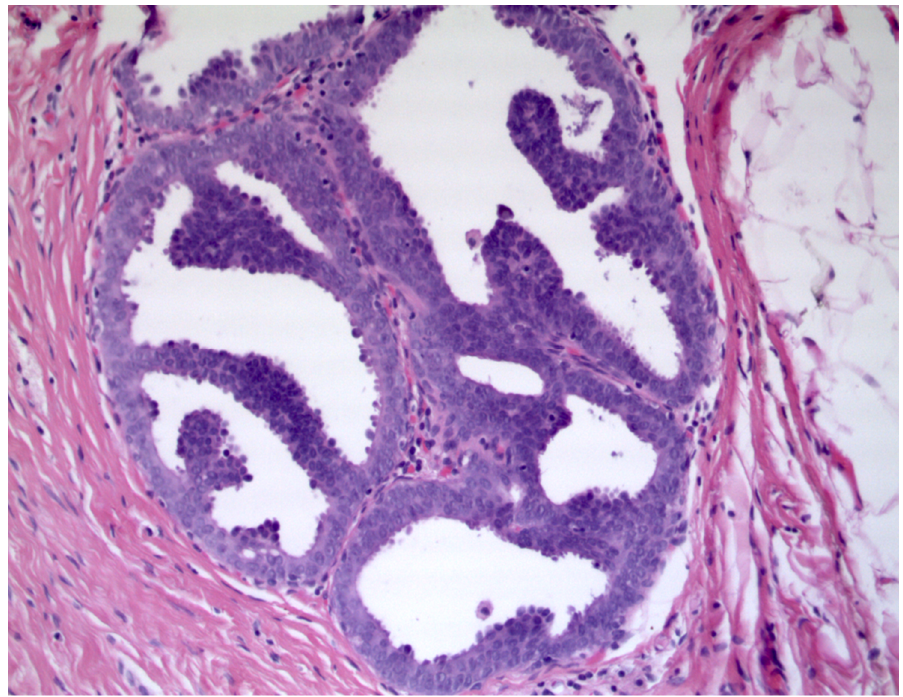
Figure 1. Atypical ductal hyperplasia with cribriform and micropapillary growth pattern (Hema- toxylin & Eosin, 400×).